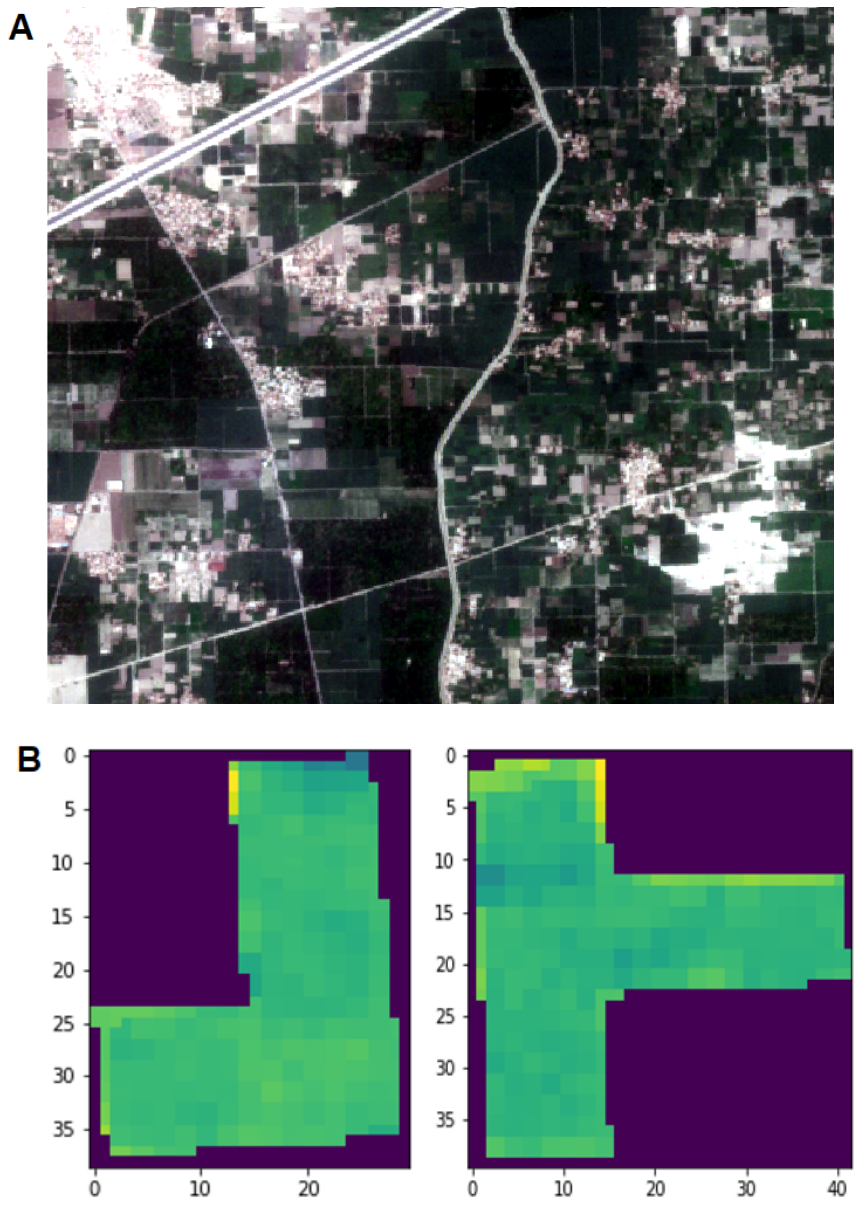
Figure 2. ( A ) A Sentinel-2 tile specimen of sugarcane fields illustrated in RGB bands. ( B ) Depiction of mapped fields obtained by stripping the large tile and visualizing in NDVI